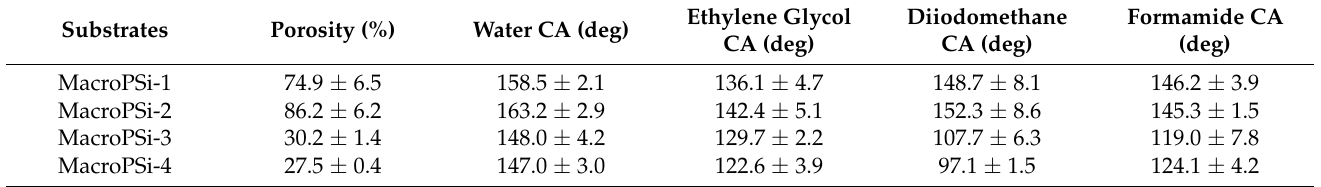
Table 5. Summary of contact angle values for MacroPSi substrates after FOTS modification using different solvents.